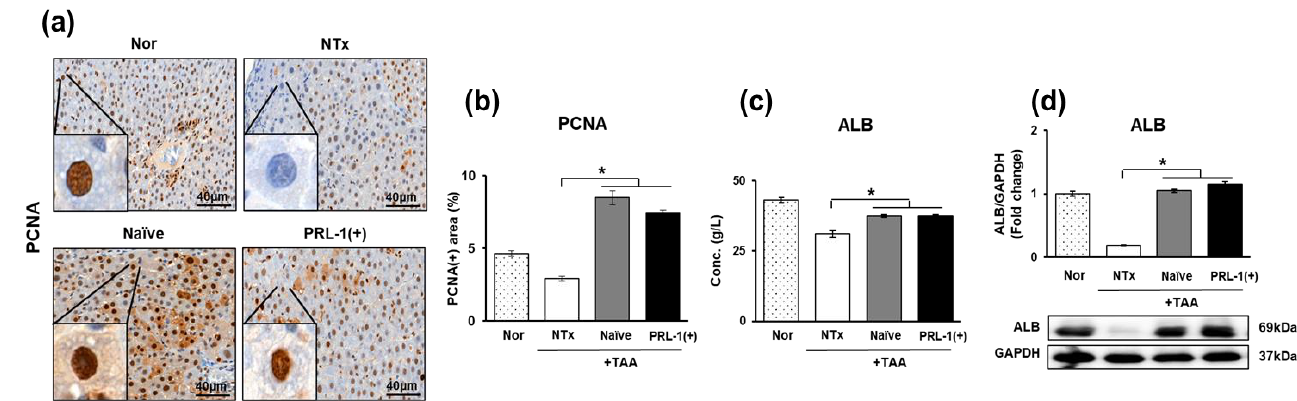
Figure 8. Effects of naïve and PRL-1(+) cells on proliferation in TAA-injured rat livers. The expression of proliferation markers in TAA-injured rat livers ( a ) and ( b ) PCNA, ( c ) and ( d ) albumin. All experiments were repeated in duplicate to triplicate. * p < 0.05.